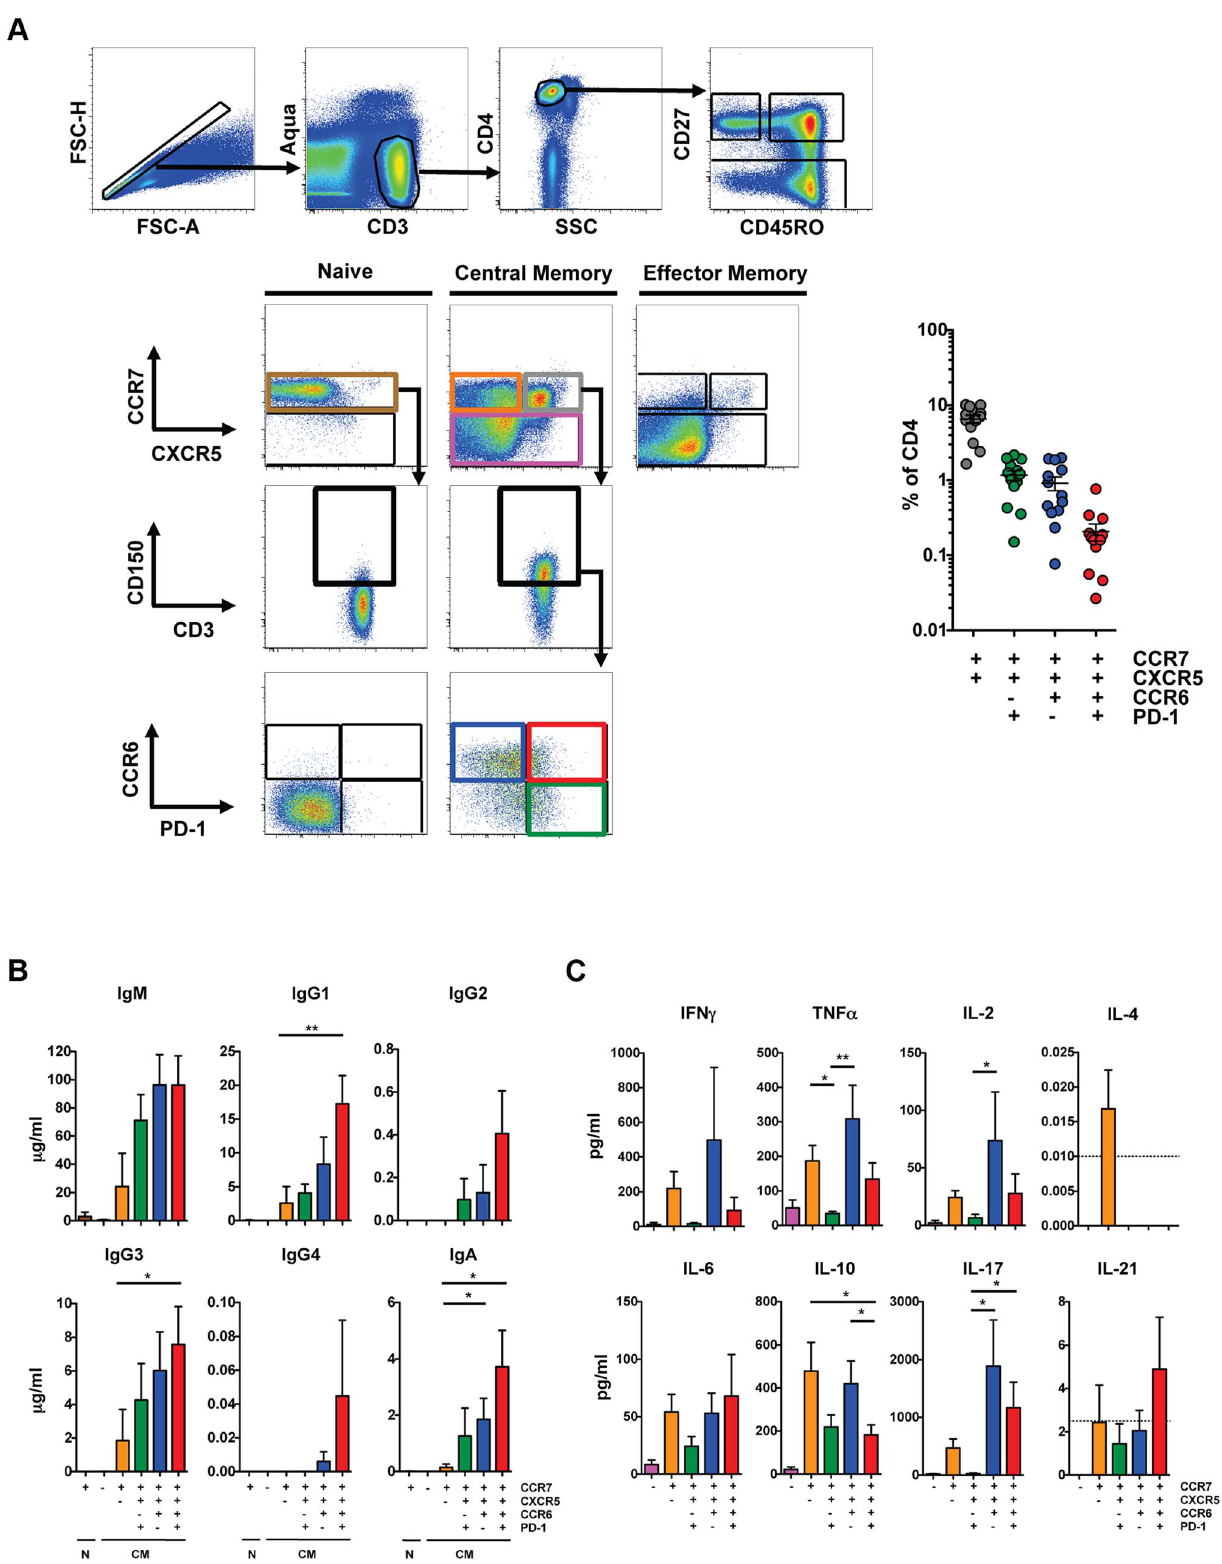
Figure 1. Characterization of peripheral T FH cells. ( A ) Left: Representative flow cytometry plots from HIV-uninfected PBMC showing the gating scheme for isolating T cell subsets for the T cell/B cell coculture assay. Isolated populations include naı¨ve cells (brown), CM CCR7 low (pink), CM CCR7 high CXCR5 low (orange), CM CCR7 high CXCR5 high CCR6 low PD-1 high (green), CM CCR7 high CXCR5 high CCR6 high PD-1 low (blue) and CCR7 high CXCR5 high CCR6 high PD-1 high (red). Before gating on CCR6 and PD-1, cells were first gated on CD150 high . Right: Scatter plot indicating the frequency of each